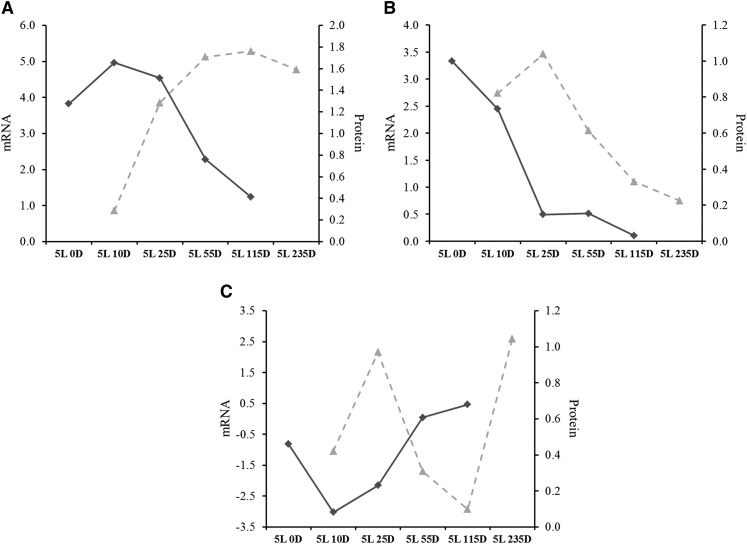
Combined mRNA/protein plots showing good correlation for (A) photolyase (MAC_05491) and (B) C2H2 transcription factor (= N. crassa CSP-1, MAC_07134) with an inverse and poor correlation for (C) polyketide synthase (MAC_09549). Solid lines refer to mRNA and dashed lines refer to protein. Values in y-axes are log2 fold-change relative to DD.